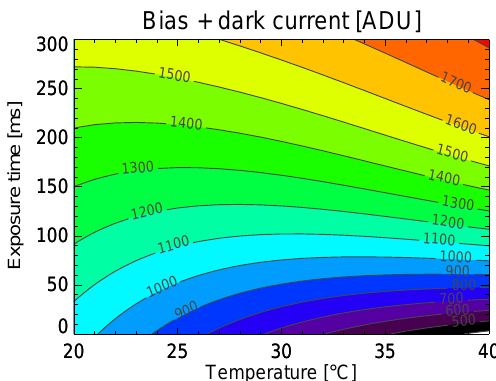
Figure 2. Calibration model of bias and dark current as a function of exposure time and temperature. The variable exposure time and di- rect exposure to weather results in a dark range of about 1000 ADU (out of a maximum of 65536 ).